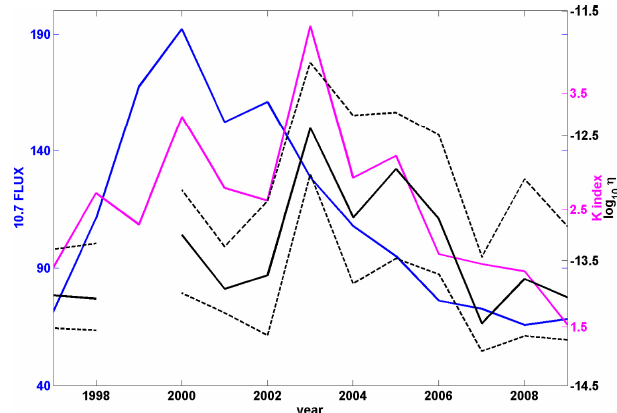
Fig. 4. Year-to year variations of log 10 PMSE volume reflectivities (black solid line) together with their quartiles (grey dashed lines), K-index (magenta line) and solar flux (blue